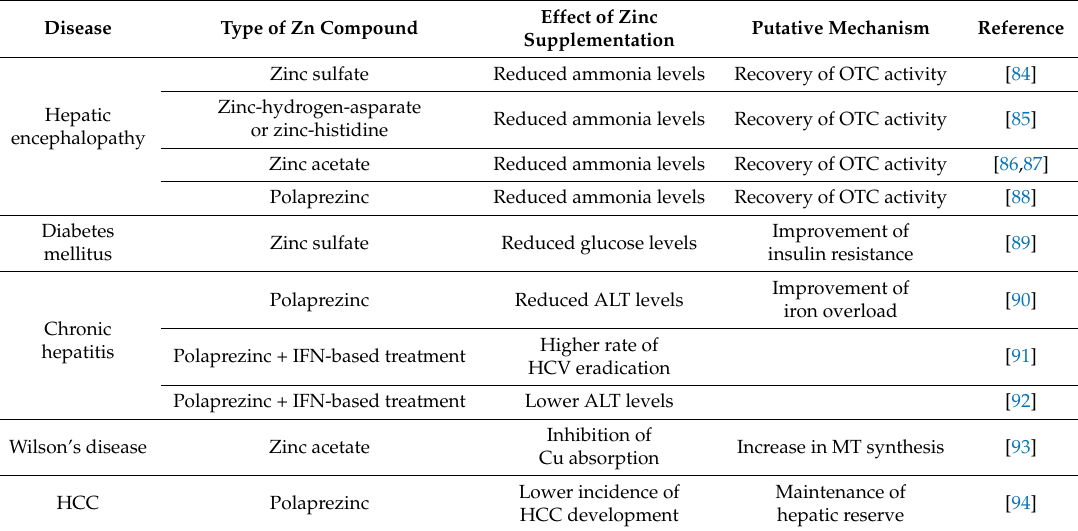
Table 2. Beneficial effects of zinc administration in patients with chronic liver